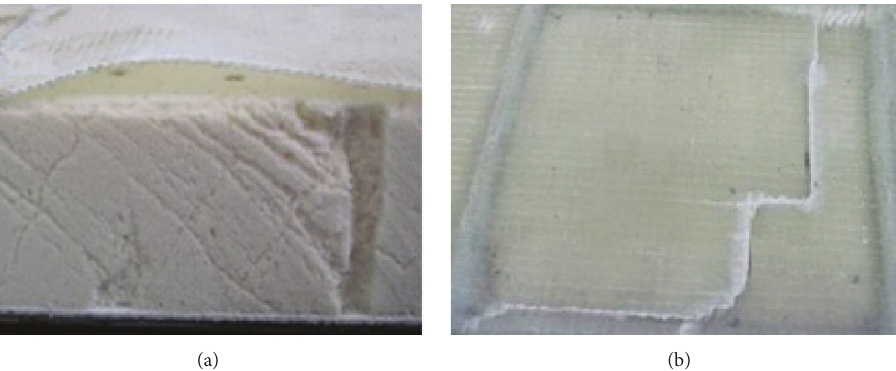
Figure 5: Failure modes (a) delamination of Specimen CON60 and (b) face sheet rupture of Specimen